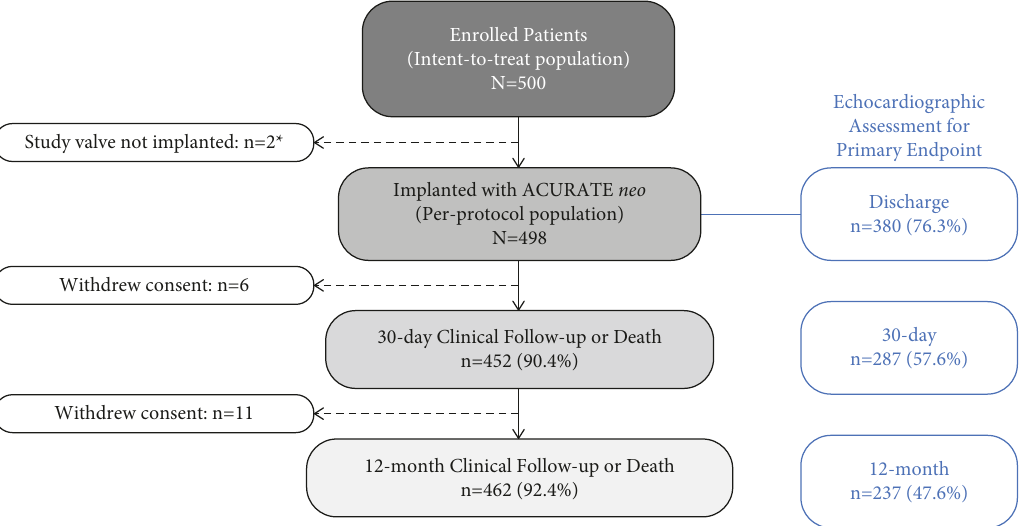
Figure 2: PROGRESS PVL study flow.